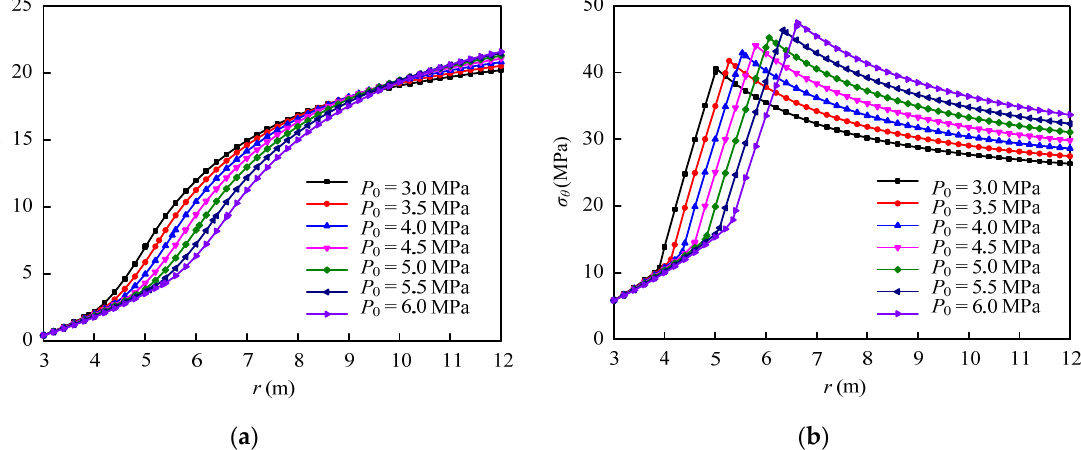
Figure 8. Effect of seepage force on the stress distribution in the tunnel surrounding rock. ( a ) σ r ; ( b ) σ θ .